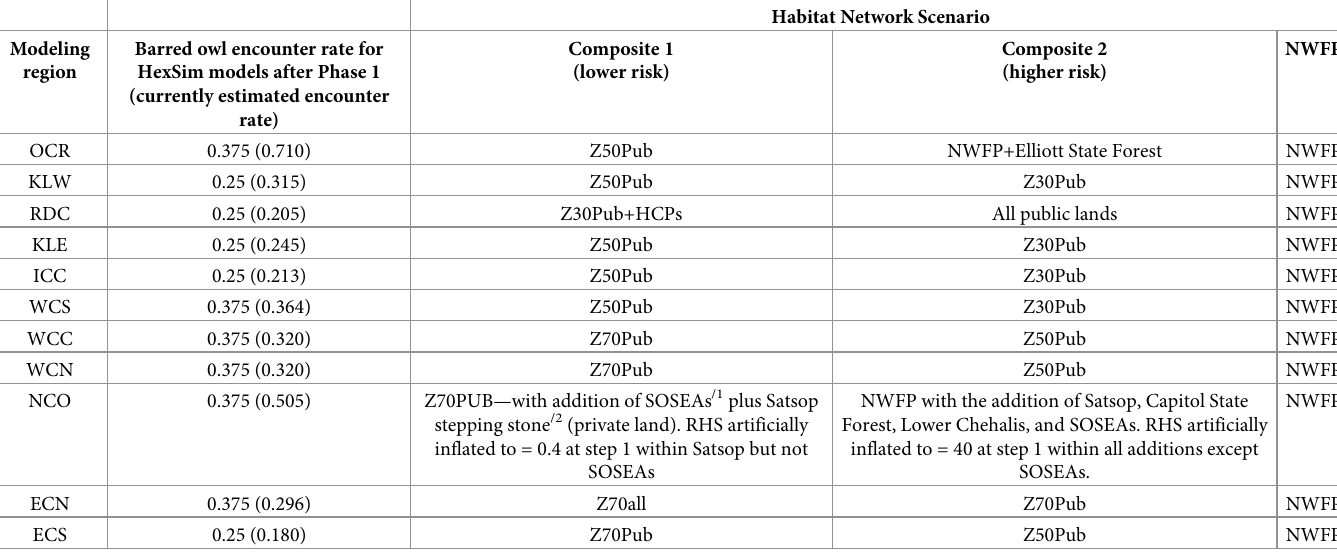
Habitat Network Scenario